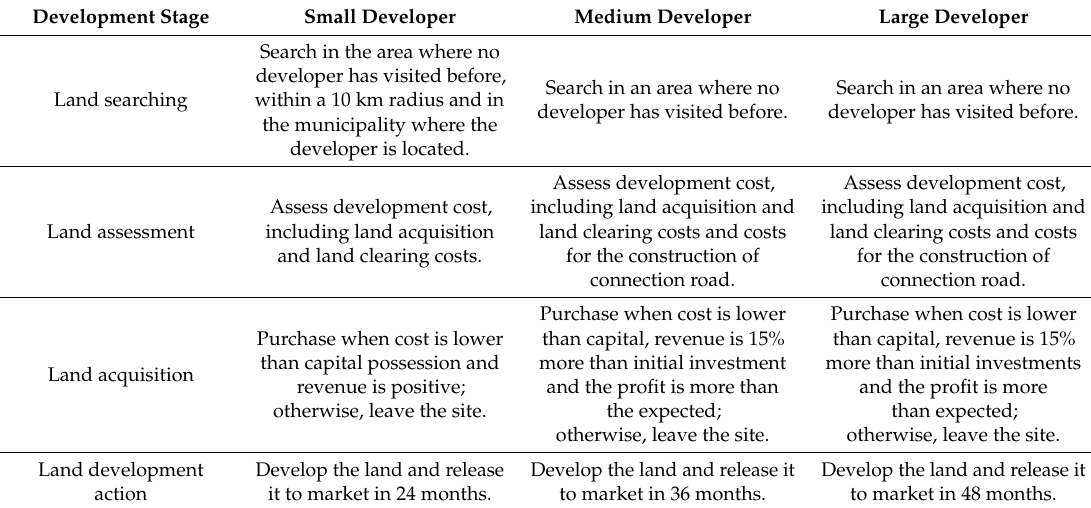
Table 2. Decision behaviours of developers during di ff erent land development